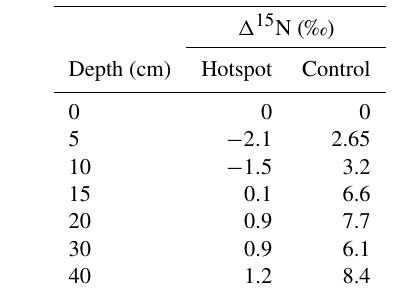
Table 2. Differences in soil δ 15 N at depth and δ 15 N in surface soils for hotspot and control depth